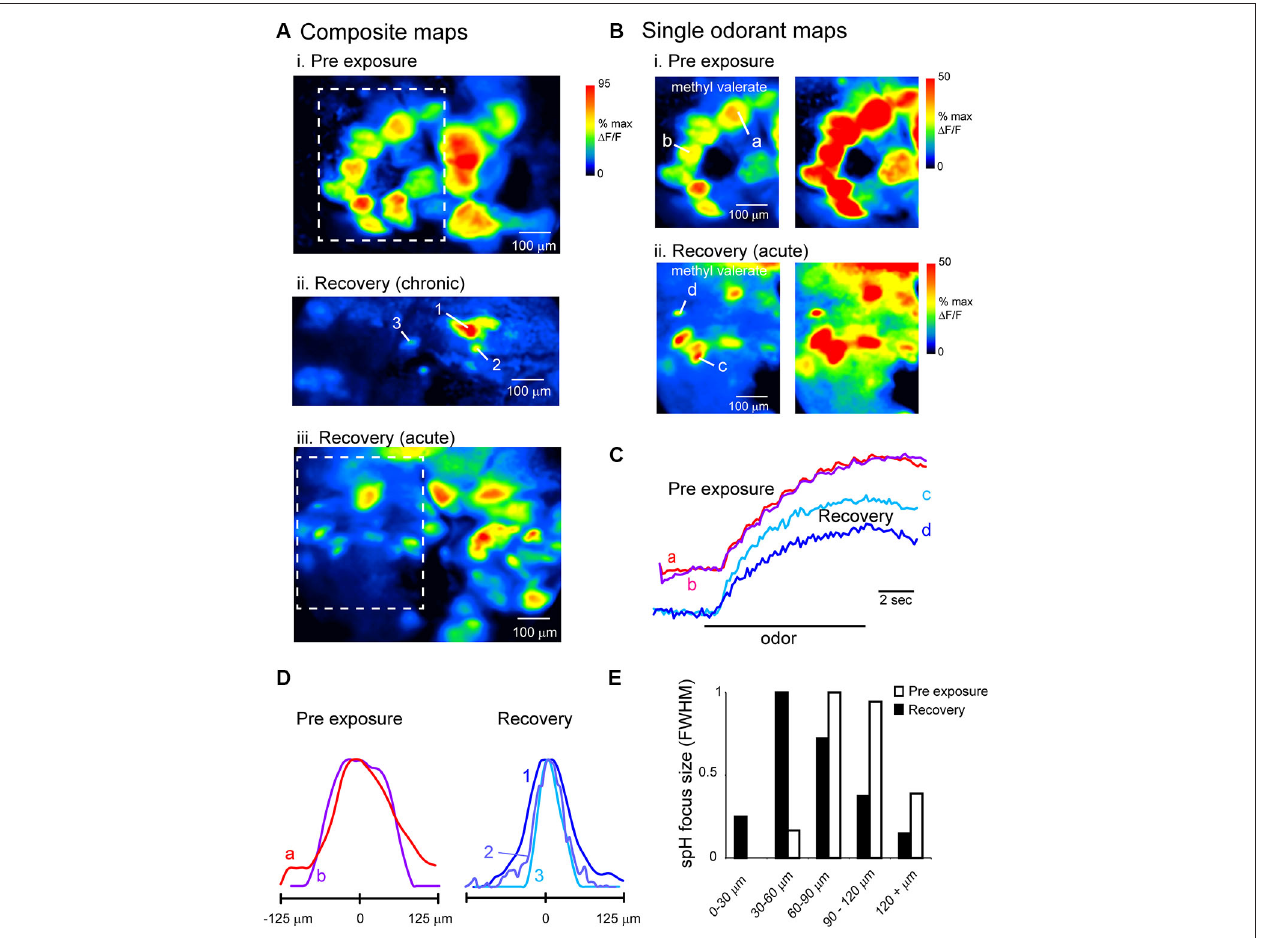
conditions (ii) . Smaller-sized foci are still apparent after rescaling. (C) Time-course of spH signal in typical and undersized foci in unlesioned (a, b) and lesion-recovered (c, d) animals. Traces taken from locations indicated in (B) . Unlesioned and lesion-recovered traces are offset and scaled separately to compare signal time-course. (D) Normalized intensity profiles through spH foci taken from response maps in unlesioned (a, b) and lesion-recovered animals (1, 2, 3; see A , ii ), indicating smaller focus size in recovered animals. (E) Histogram of spH focus sizes for pre-exposure and lesion-recovered preparations. Lesion-recovered animals show an increase in the number of foci below 60 µ m full-width at half-maximum (FWHM). Bin size of the histogram (20 µ m) is 1 standard deviation of the FWHM values for pre-lesion